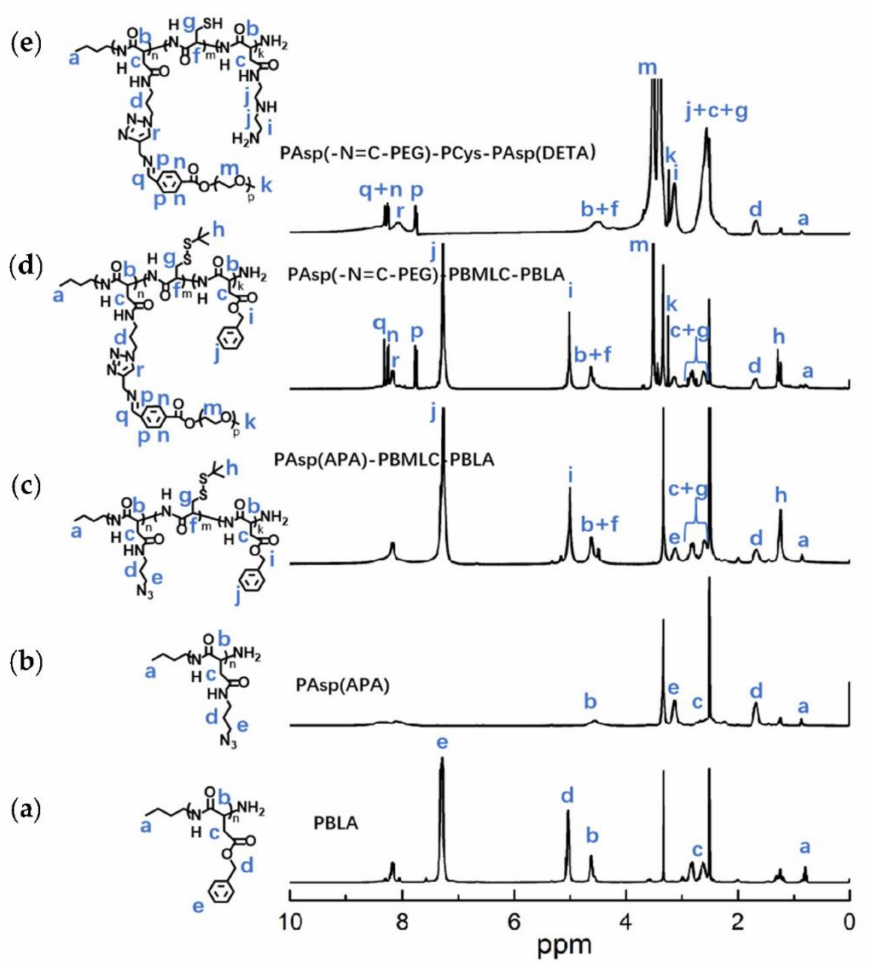
Figure 6. 1 H-NMR analyses of ( a ) PBLA, ( b ) PAsp(APA), ( c ) PAsp(APA)-PBMLC-PBLA, ( d ) PAsp(- N=C-PEG)-PBMLC-PBLA and ( e ) PAsp(-N=C-PEG)-PCys-PAsp(DETA) in DMSO- d6